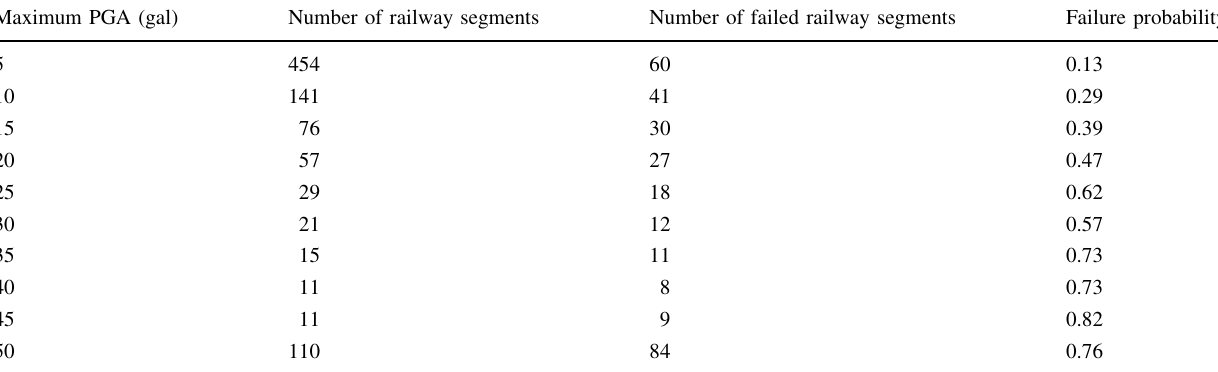
Fig. 4 Train disruptions induced by earthquake hazards, 2012–2019. a Spatial distribution of train disruptions and corresponding earthquakes and b frequency-magnitude distribution of earthquakes that caused train disruptions Table 4 Failure probability of the railway segments under different maximum peak ground acceleration (PGA), 2012–2019